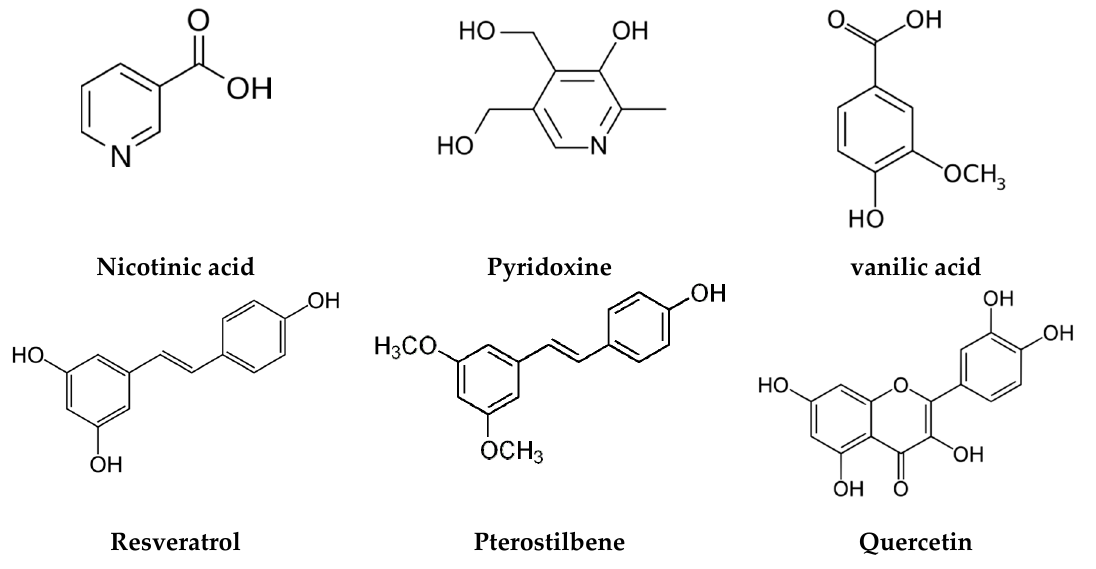
Scheme 4. Molecular structure of a few nutraceutical molecules widely used as cocrystal former.